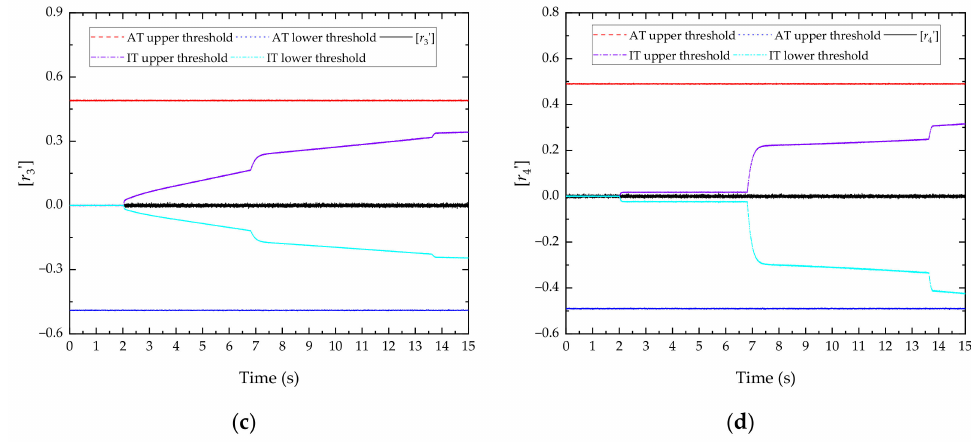
Figure 19. Landing gear selector valve reversing stuck fault detection results: ( a ) [ r 1 (cid:48) ] ( b ) [ r 2 (cid:48) ] ; ( c ) [ r 3 (cid:48) ] ; ( d ) [ r 4 (cid:48) ] .